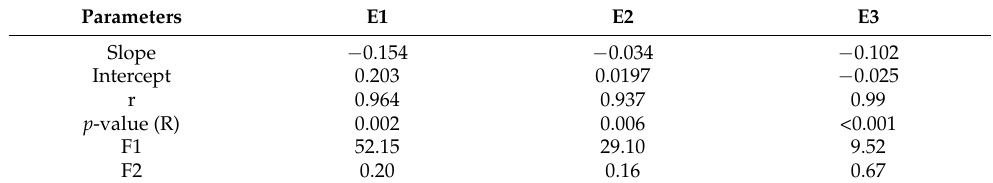
Table 5. The parameters of linear regression of average ln C n /C 0 changed with time for E1, E2 and E3.